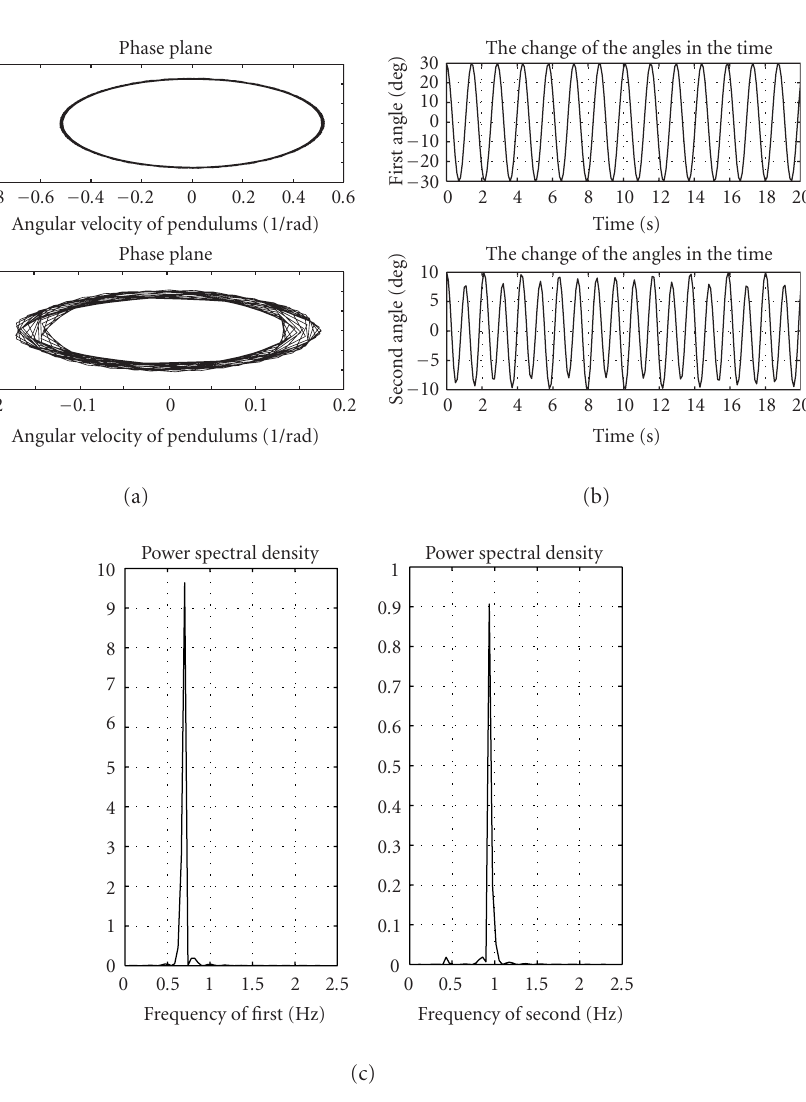
Figure 3.5. (a) “Phase portraits” for the two pendulums; (b) swinging angles ϕ 1 ( t ) and ϕ 2 ( t ); (c) oscillation spectrum distributions for the two pendulums. Parameters are m 1 = m 2 = 1 . 57 kg, L 1 = L 2 = 0 . 3 m, Ψ = 90 ◦ . Initial conditions are ϕ 1 = 30 ◦ , ϕ 2 = 10 ◦